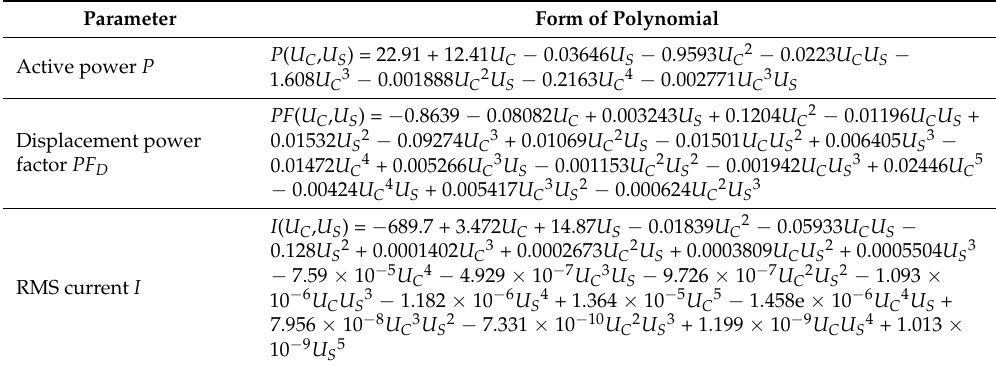
Table 7. Form of the approximating polynomials for analysed